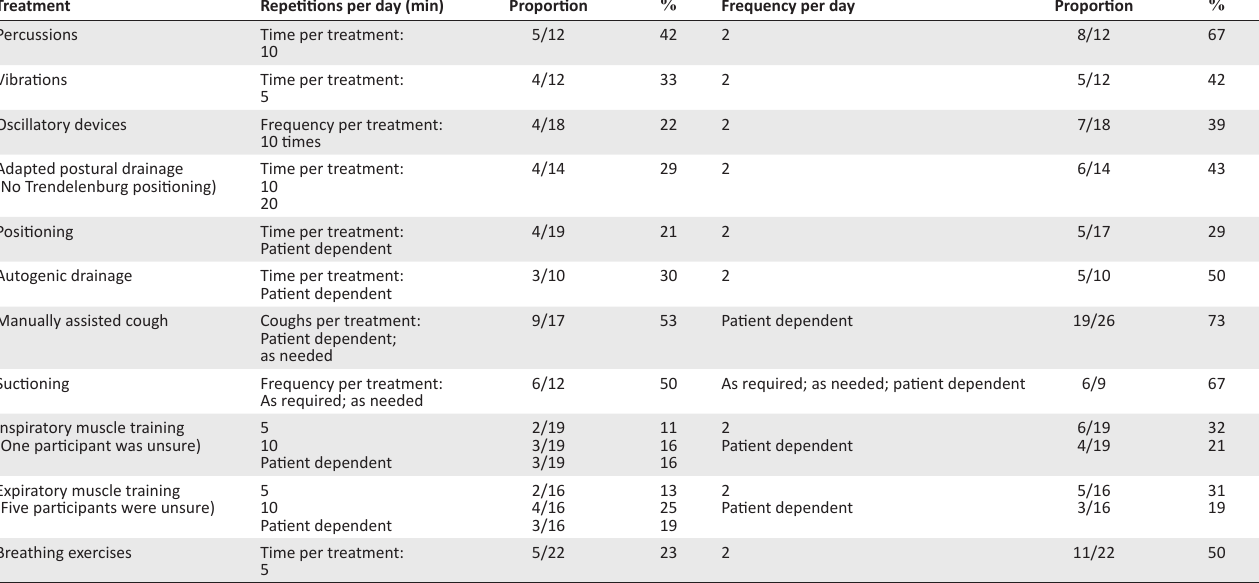
TABLE 2: Summary of suggested treatment duration and frequencies for respiratory muscle training, lung compliance and airway clearance techniques (chronic care).